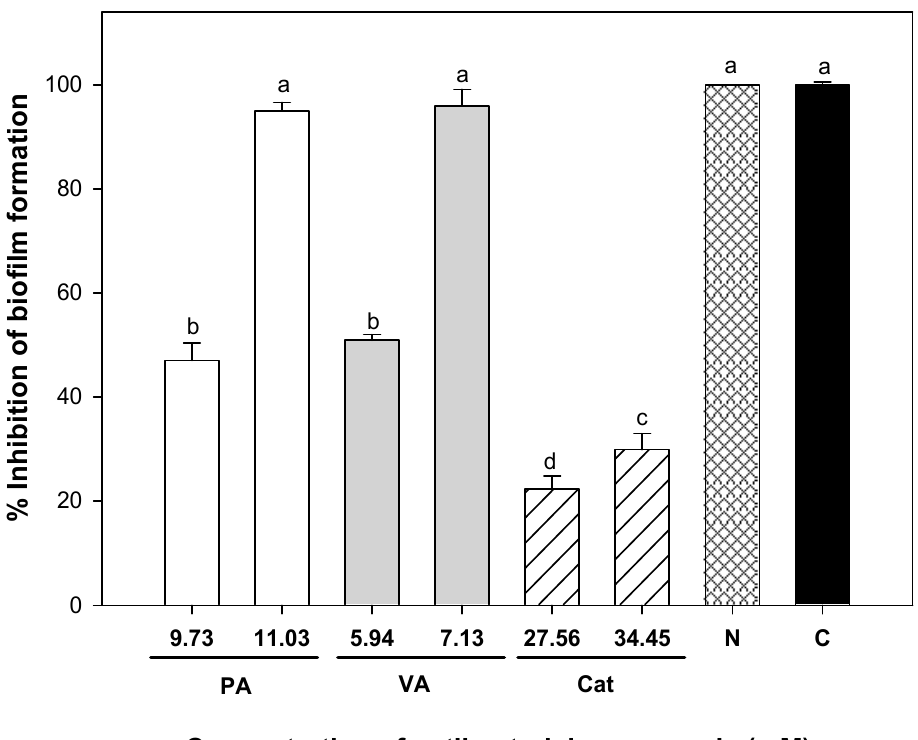
Figure 3. Percentage of the inhibition of uropathogenic E. coli biofilm formation incubated for 24 h at 37 °C in the presence of single and combined phenolic compounds determined by crystal violet assay. Means for three independent experiments ± deviation standard are illustrated. PA = protocatechuic acid, VA = vanillic acid, Cat = catechin, N = nitrofurantoin 0.4 mM, C = Combination (1.62 mM protocatechuic acid, 0.74 mM vanillic acid, and 0.05 mM catechin). Different letters indicate significant differences among treatments ( p ≤ 0.05). The initial inoculum added to the system was 3 Log CFU/mL.